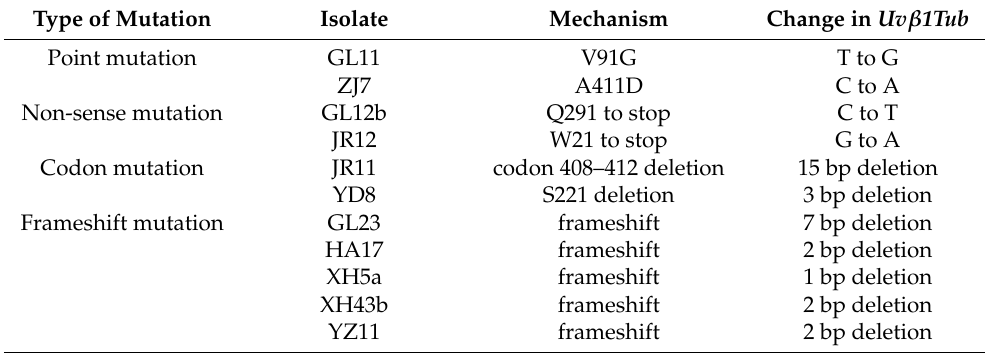
Figure 5. Correlation of log10-transformed concentration at which mycelial growth is inhibited 50% (EC 50 ) values of Ustilaginoidea virens isolates for carbendazim and ( A ) diethofencarb, ( B ) azoxystrobin, ( C ) pyraclostrobin, and ( D ) tebuconazole. Table 3. Mutations of Uv β 1Tub in carbendazim resistant isolates of Ustilaginoidea virens. Type of